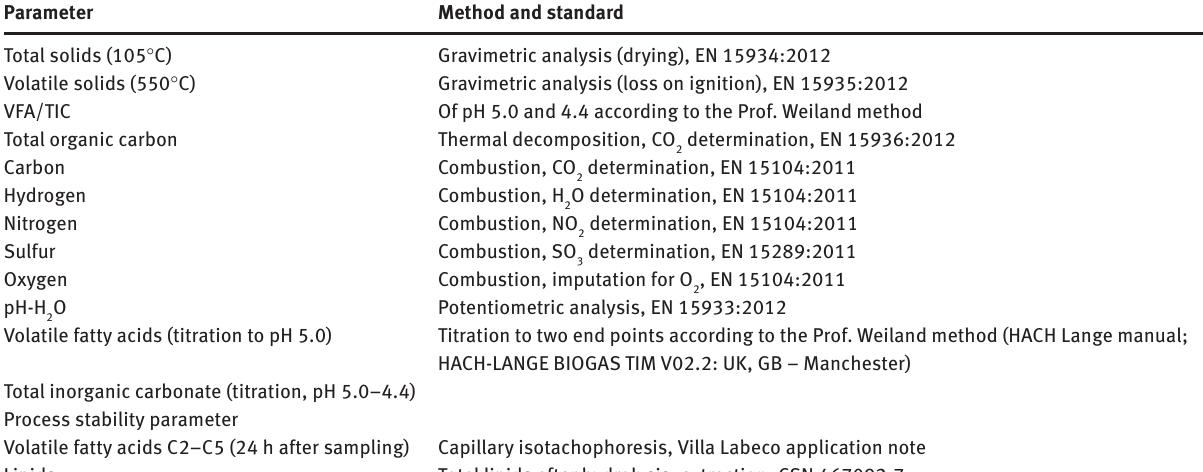
Table 2: Methods and standards. Parameter Method and